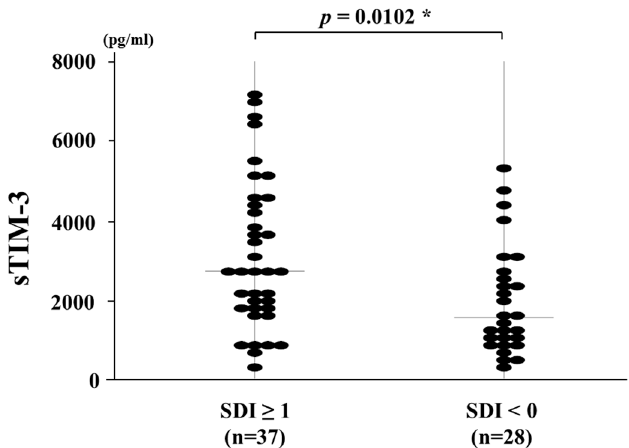
Figure 4. Serum sTIM-3 levels in SLE patients with or without organ damage. Comparison of serum sTIM-3 levels between SLE patients with at least one organ damaged (SDI ≥ 1) and those without organ damage (SDI = 0). Raised serum sTIM-3 levels were shown in SLE patients with at least one organ damage compared with those without organ damage. sTIM-3: soluble T-cell immunoglobulin and mucin-domain-containing molecule 3, SDI: Systemic Lupus International Collaborating Clinics / American College of Rheumatology Damage Index. *, p < 0.05 is considered as statistically